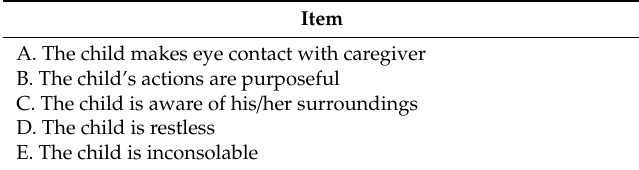
Table 1. The Paediatric Anaesthesia Emergence Delirium (PAED)